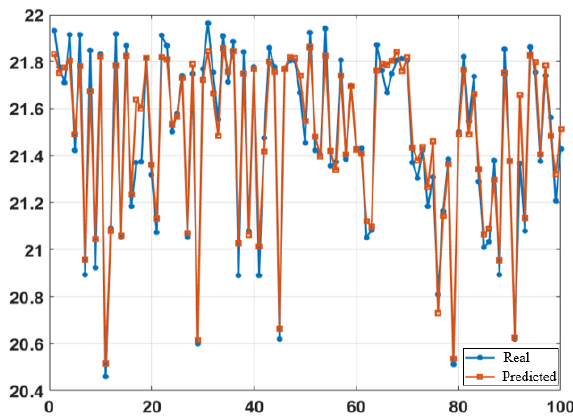
Figure 10. Comparison of the real values and predictions of the MVGG-19 model.